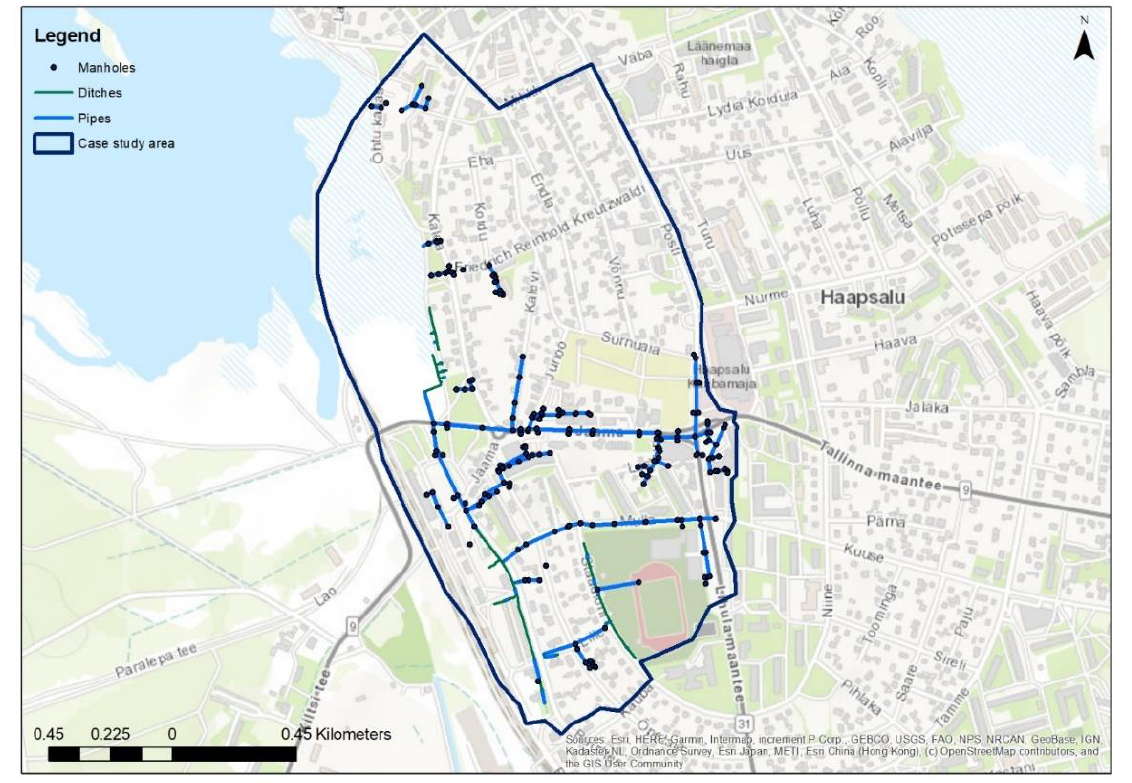
Figure 5. Haapsalu case study area.